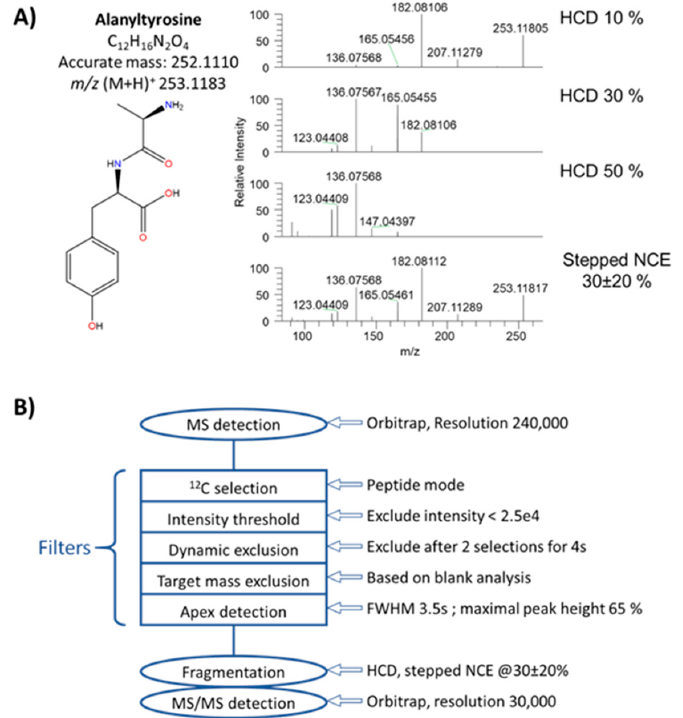
Figure 1. Implementation of an “HCD-only” DDA acquisition workflow. ( A ) MS / MS spectra of alanyltyrosine obtained upon HCD activation at 10%, 30% and 50%, and stepped HCD at 30% ± 20%. ( B ) Schematic overview of the “HCD-only” DDA method (More detailed information regarding experimental conditions and filters is given in Supplementary Material, Table S2).